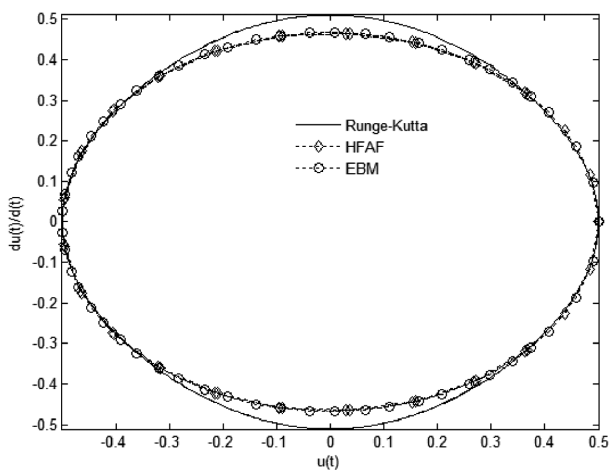
Fig. 11. Phase-plan diagram for fi rst mode, when A = 0.5.